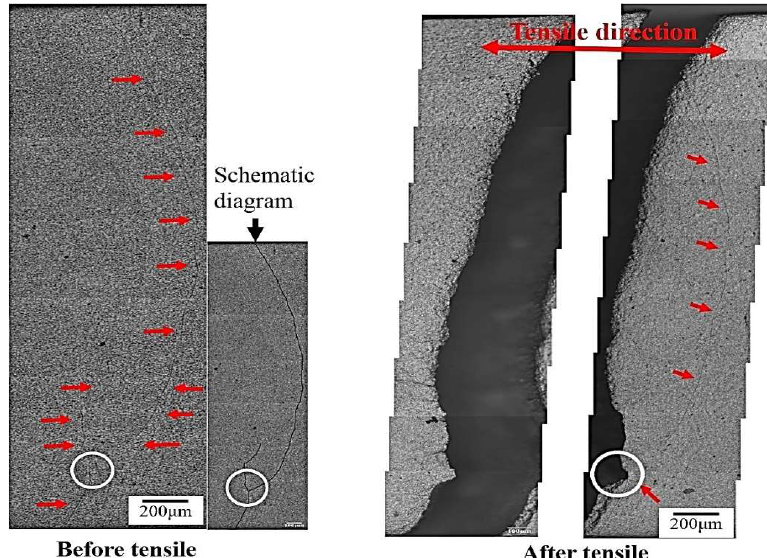
Figure 7. Microstructure of tensile deformation of the 1670-NA specimen (discontinuous arrangement assembled by intermetallic particles and micro-voids (arrow) and two discontinuous intermetallic particle lines crossing each other (circle)).